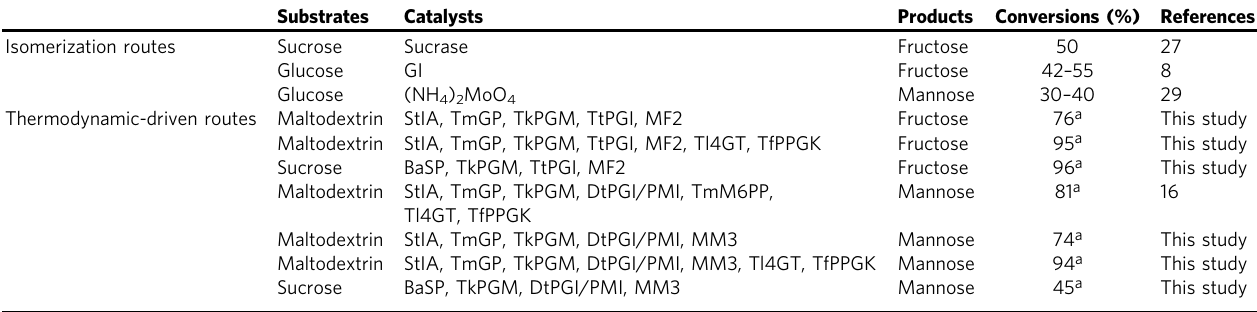
Table 2 Comparison of isomerization methods and thermodynamically driven routes for fructose and mannose